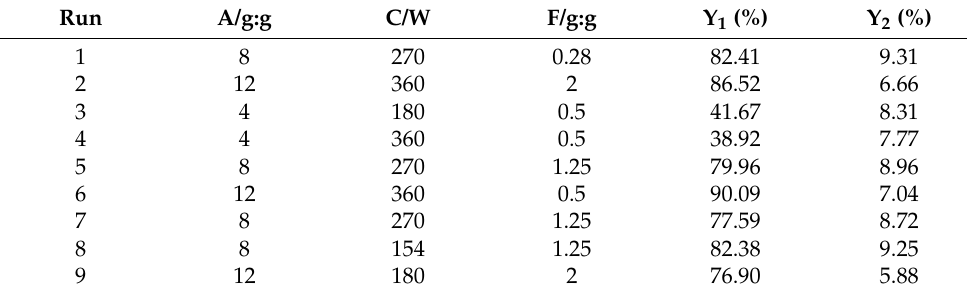
Table 7. Design and results of CCD with Y 1 and Y 2 as